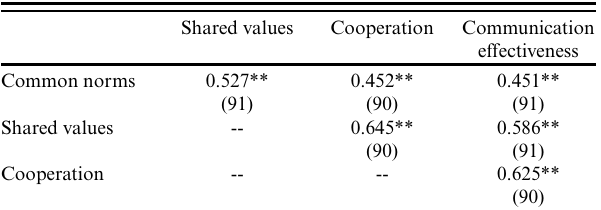
Table 2 . Correlations among the four cognitive social capital